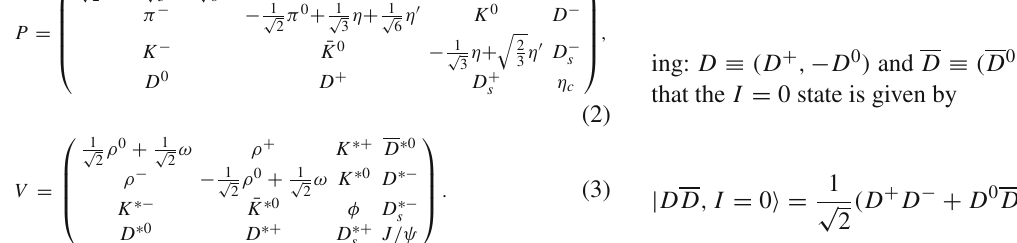
Fig. 2 Hadronization of the c ¯ c quark